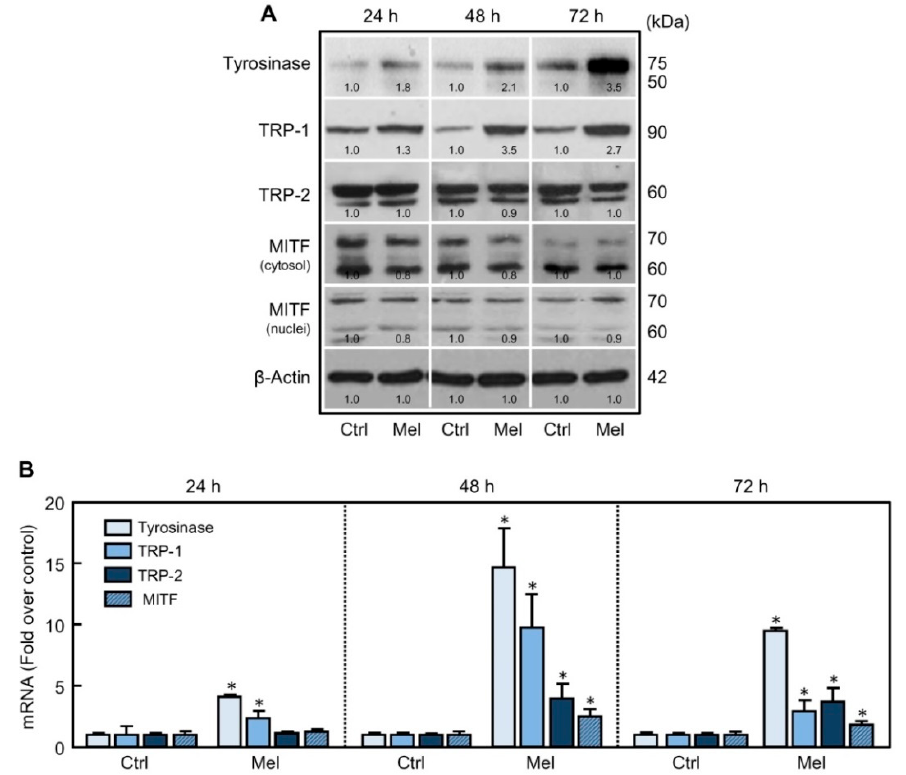
Figure 2. Effect of melatonin on the expression of melanogenesis-related proteins and pigmentation-related genes. ( A ) The cells were incubated with 1 mM melatonin (Mel) for the period of time specified and tyrosinase, TRP-1, TRP-2, and MITF were analyzed by immunoblotting; as a loading control, β -actin was also determined. ( B ) The cells were treated as in (A) and the mRNA levels of tyrosinase, TRP-1, TRP-2, and MITF were determined by real-time quantitative RT-PCR analysis; data were normalized to endogenous glyceraldehyde 3-phosphate dehydrogenase expression levels and expressed as fold changes over control group. * p < 0.05 vs. control group (Ctrl).